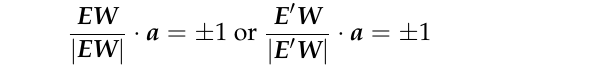
Figure 7. ( a ) Singular configuration corresponding to θ 6 = 0 or π, θ 3 = 0; ( b ) Singular configuration corresponding to θ 6 = 0 or π, θ 3 = π.